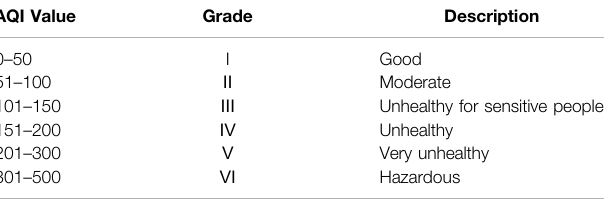
TABLE 1 | AQI values, grade, and